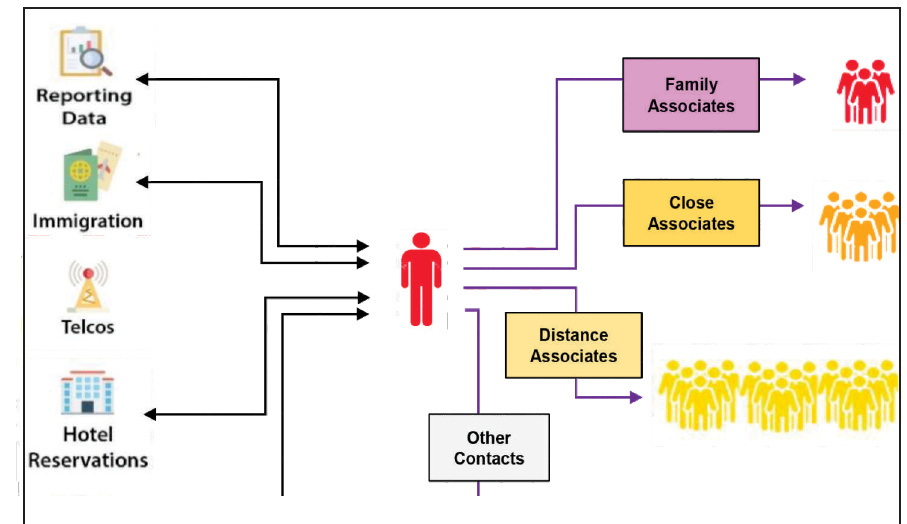
Figure 3: Operationalization of the DIT Model Epidemiology